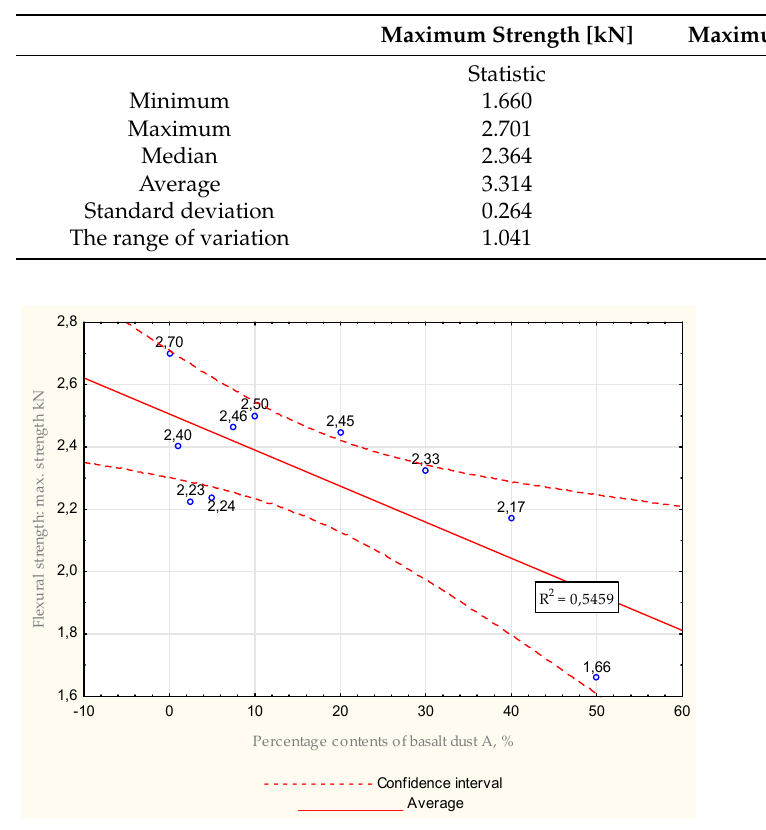
Figure 23. Average values obtained during flexural strength tests for water − mix ratio = 0.7, maximal strength.